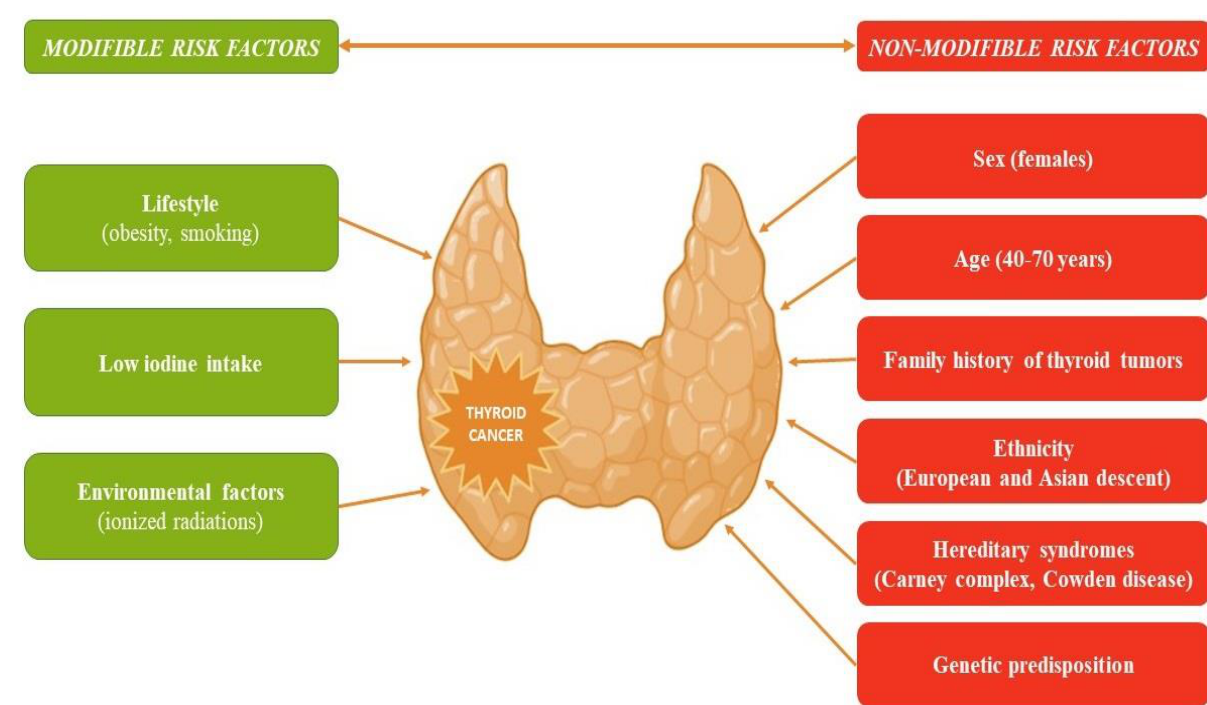
Figure 1. Risk factors that increase the likelihood of developing thyroid cancer.